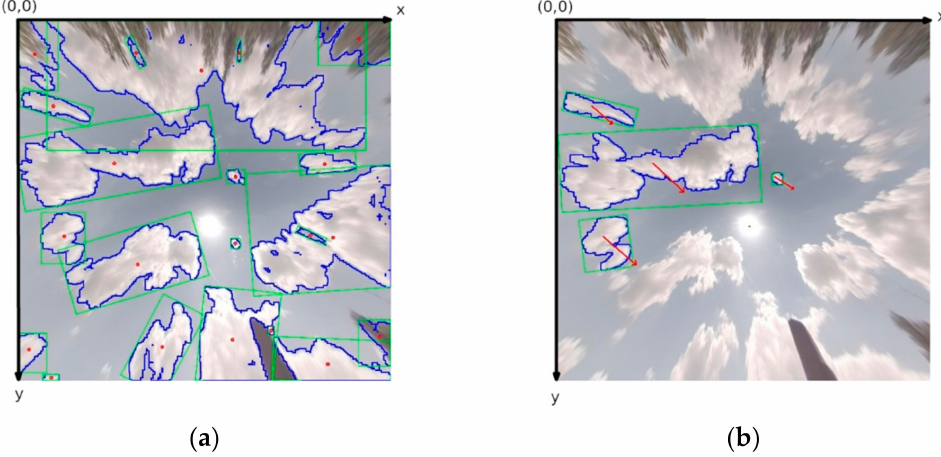
Figure 8. Cloud centroid position change within 5 min: ( a ) detected clouds, ( b ) candidate clouds for sun